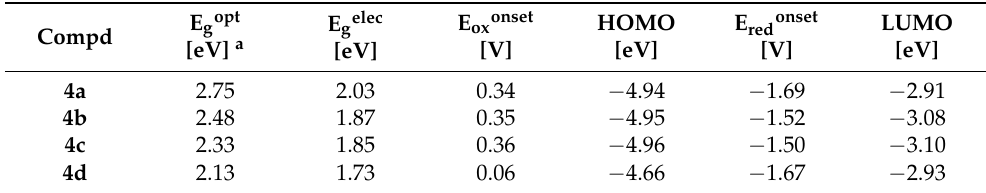
Table 2. Electrochemical properties of the